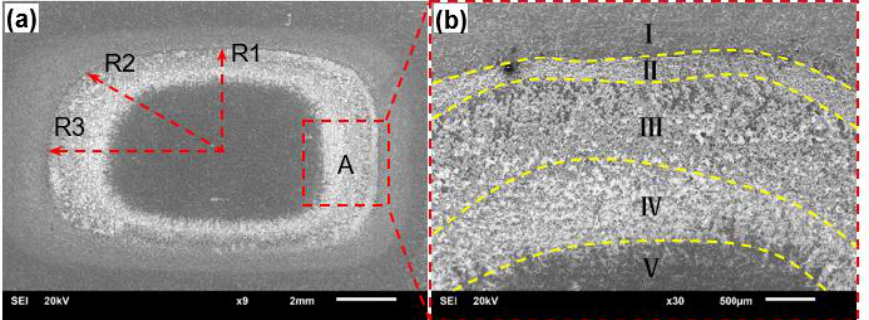
Figure 2. ( a ) An overall view of the interfacial fracture surface on the steel side of an EMPWed Al/steel tensile lap shear sample, and ( b ) a magnified view of zone A (with an image rotation of 90°), showing a hierarchical morphology from layers I to V.